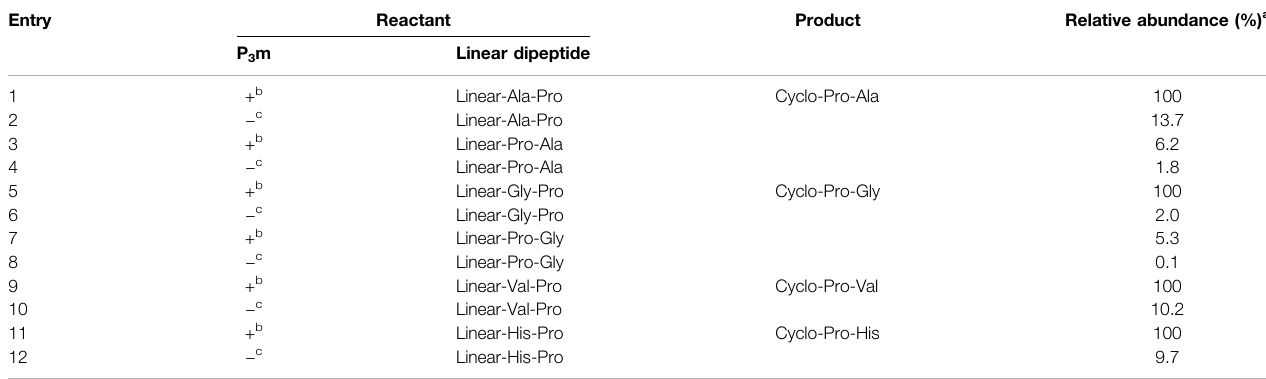
TABLE 1 | Relative abundance of the products from the reaction of proline-containing linear dipeptides with or without P 3